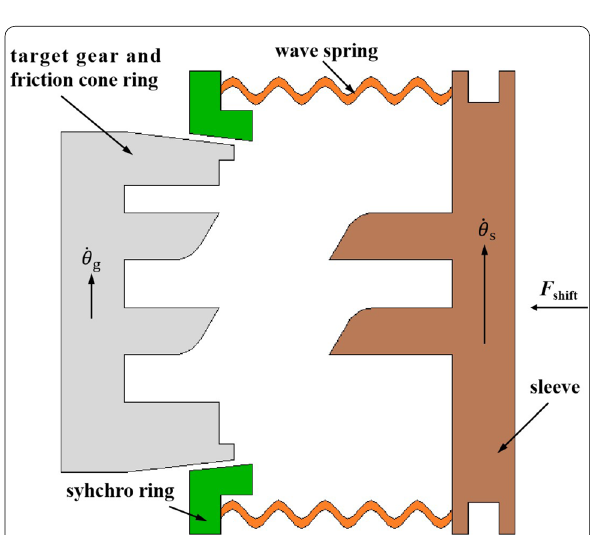
Figure 13 Schematic diagram of the structure of the sleeve in the middle position of the